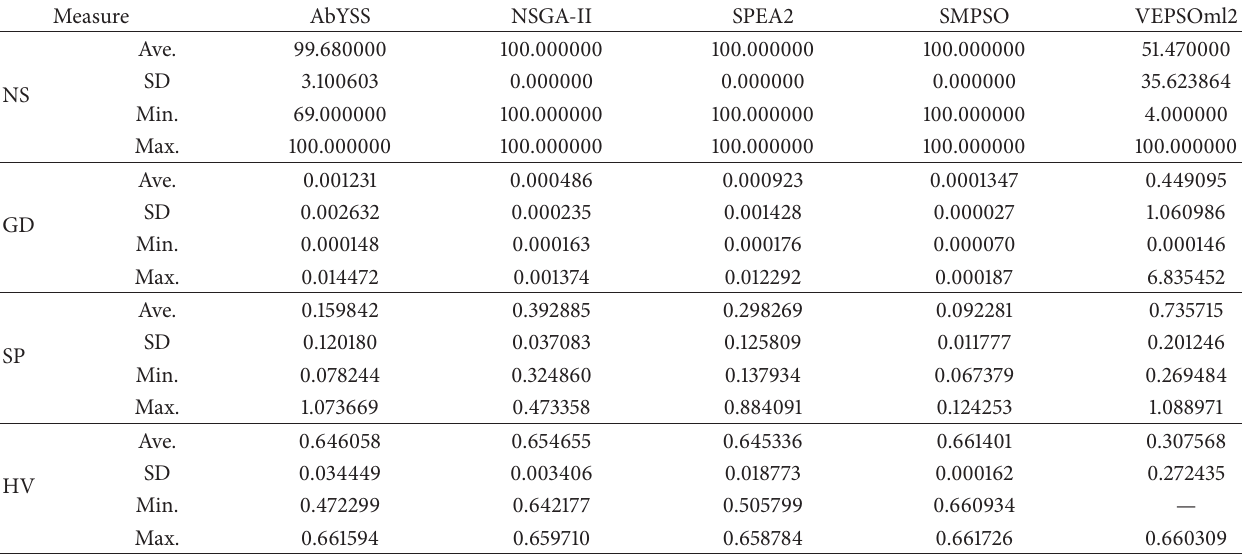
Table 10: Performance comparison based on ZDT4 test